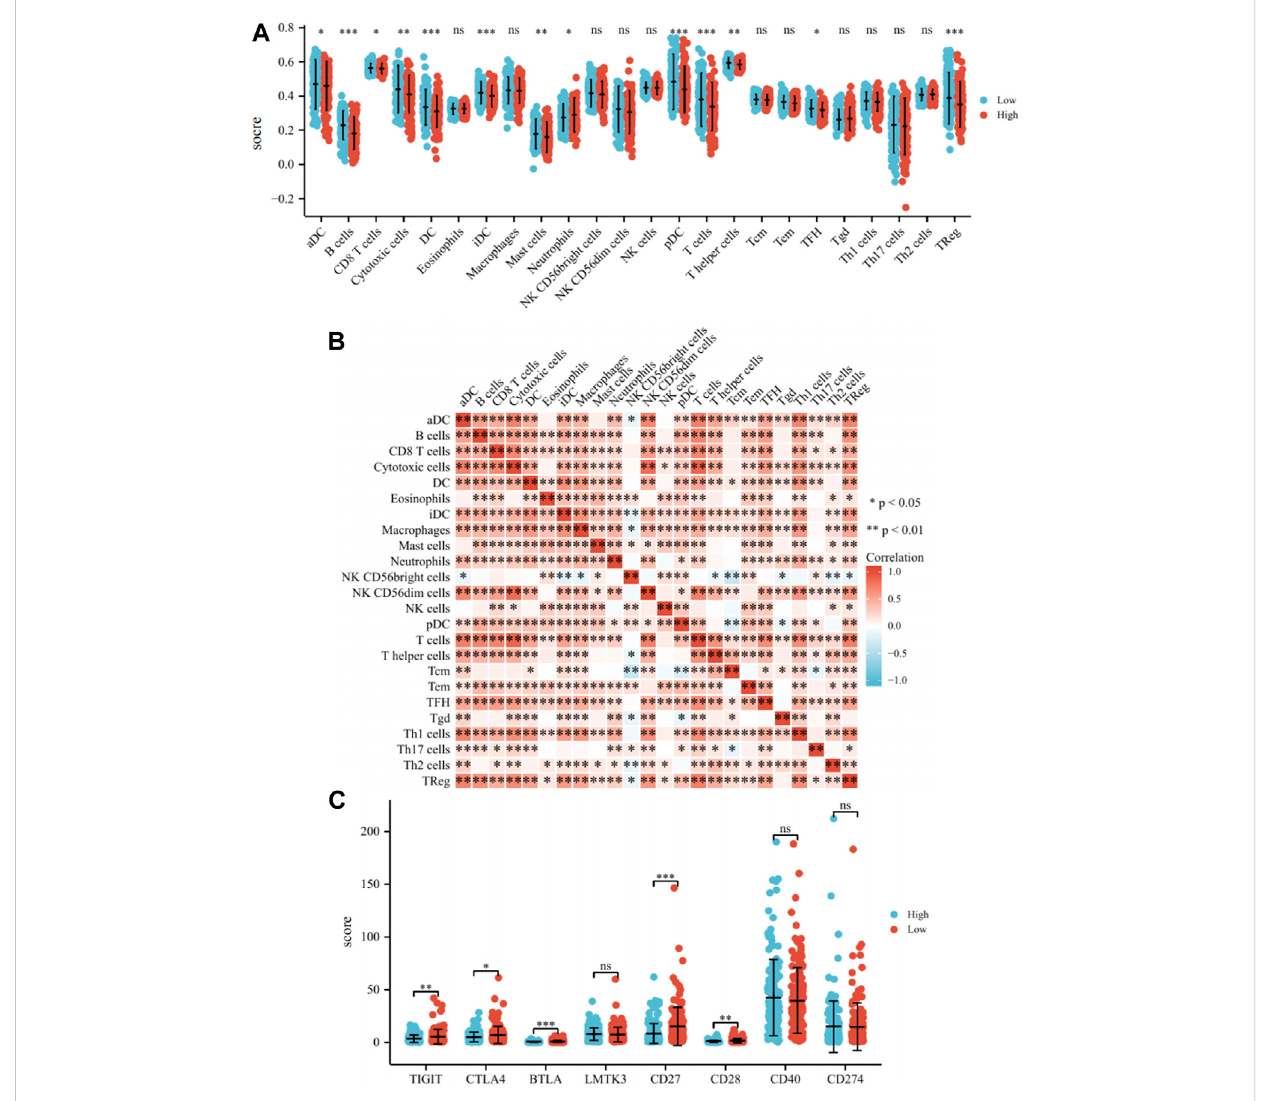
FIGURE 5 Analysis of the immune microenvironment. (A) Differences of 24 immune cells in different expression levels of Risk score. (B) Correlation between 24 immune cells. (C) Differences of immune checkpoint inhibitors in different expression levels of Risk score. Note: ns: no signi fi cant difference, *: p < 0.05, **: p < 0.01, ***: p <